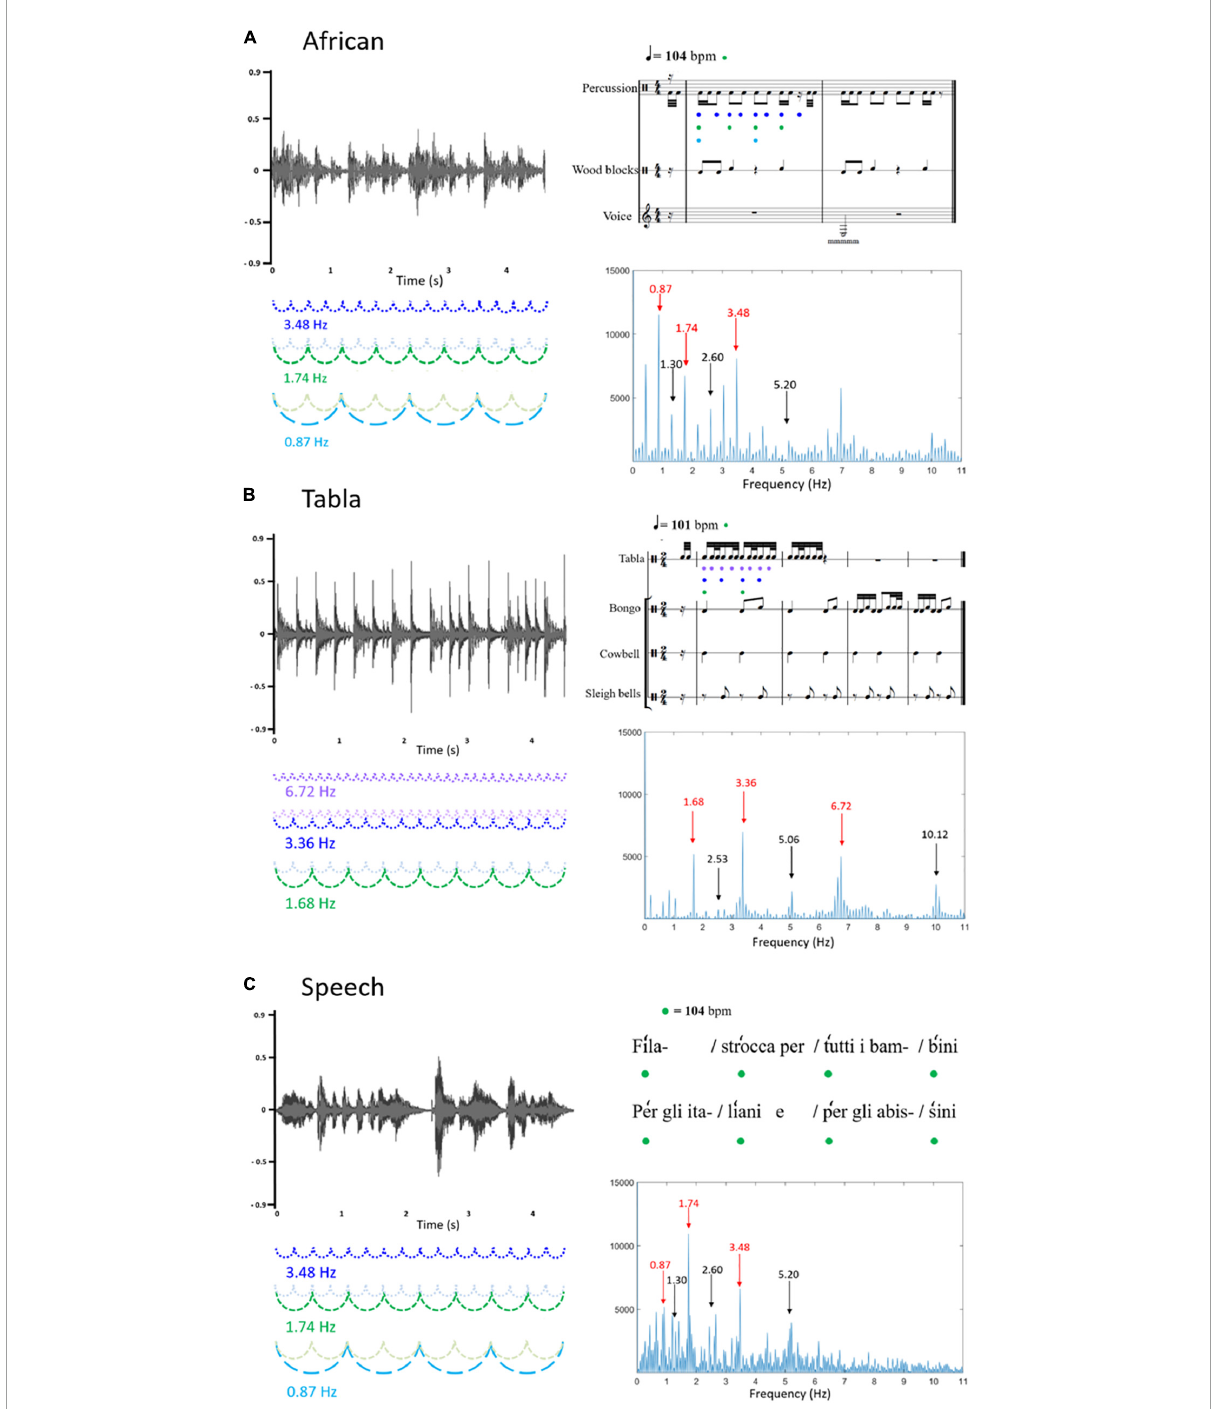
FIGURE1 Graphical representation of the three sound stimuli: (A) African musical stimulus; (B) Tabla musical stimulus; (C) Speech stimulus. On the left, the three sound waveforms are reported (x-axis: time; y-axis: sound amplitude). On the right, the upper figures represent the rhythmic patterns, depicted in musical notation (A,B) or speech metric structure (C) ; the bottom figures represent the frequency spectrums of the stimulus sound envelopes ( x -axis: frequency; y -axis: magnitude). In the frequency spectrums, peaks at frequencies corresponding to the rhythm envelope are reported in red, whereas peaks at frequencies not corresponding to the rhythm envelope, considered as noise floor, are reported in black. Frequencies corresponding to the rhythm envelope are represented on the left, coupled with the sound waveforms, and on the upper right, coupled with musical notation or speech metric structure. In detail, it can be noted that for the African musical stimulus (A) frequency 3.48 Hz